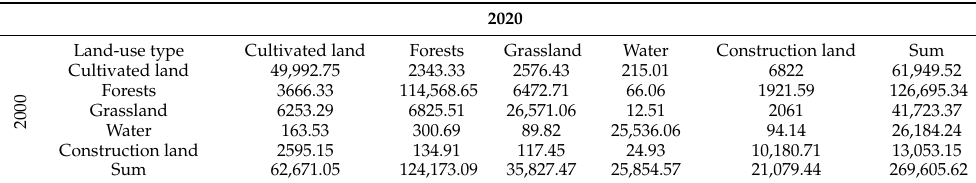
Table 4. Land-use change in the Erhai Lake basin from 2000 to 2020 (km 2